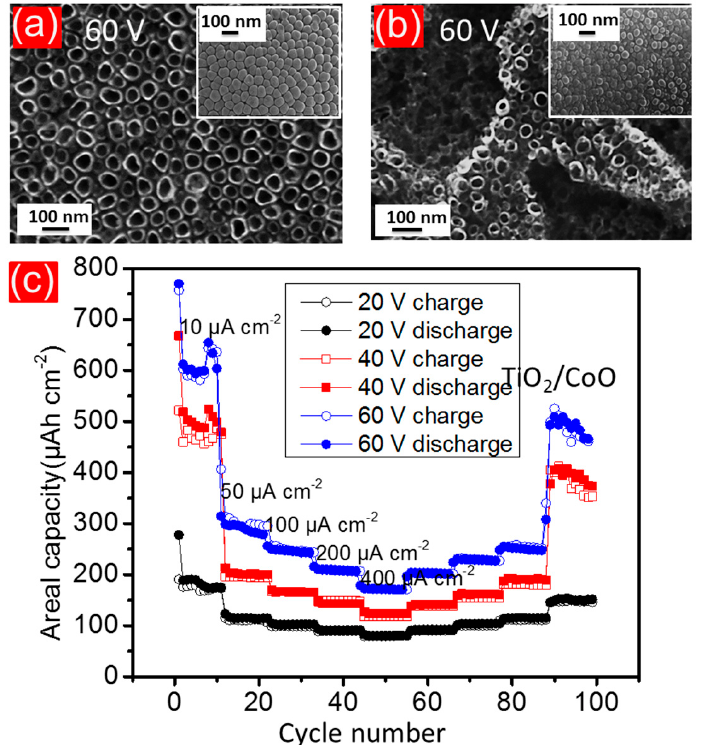
Figure 16. ( a ) SEM images of the Ti − Co alloy anodized at 60 V with the β -Ti phase, and ( b ) the Ti 2 Co phase. ( c ) Rate capability of TiO 2 /CoO, prepared at anodization voltages of 20 V (black circles), 40 V (red squares) and 60 V (blue circles), as a function of cycle number. The filled symbols relate to the discharging and open symbols to the charging processes. Adapted with permission from ref. [125].